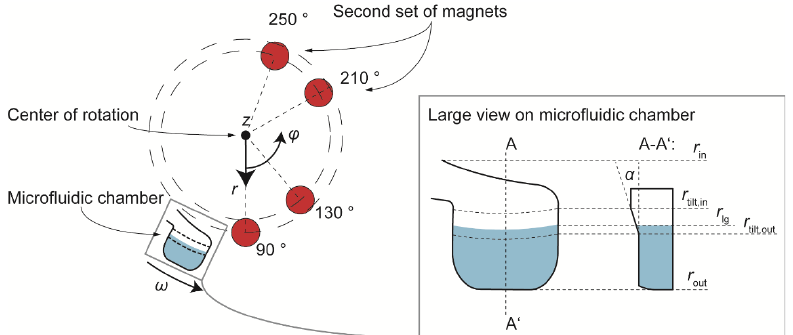
Figure 3. Left : The updated configuration (and the final one, compared to Figure 2) in which a second pair of magnets is added in order to enhance the area over a full rotation along which magnetic force is exerted on the magnetic beads. Right : A special shape of the microfluidic chamber in which an inclined top side of the chamber between r tilt,in and r tilt,out enables the z ‐ component of magnetic force to contribute to the radial bead motion.